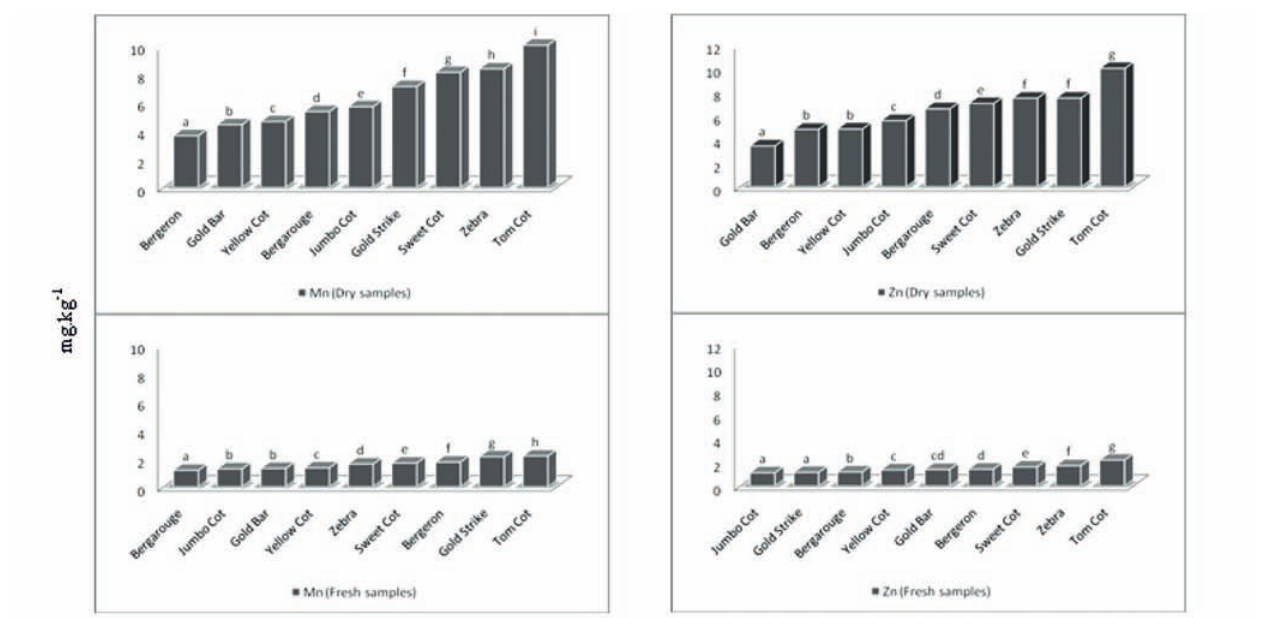
Figure 5. Concentration of Manganese in apricot cultivars (mg.kg-1), columns with different caption have a significant difference (P